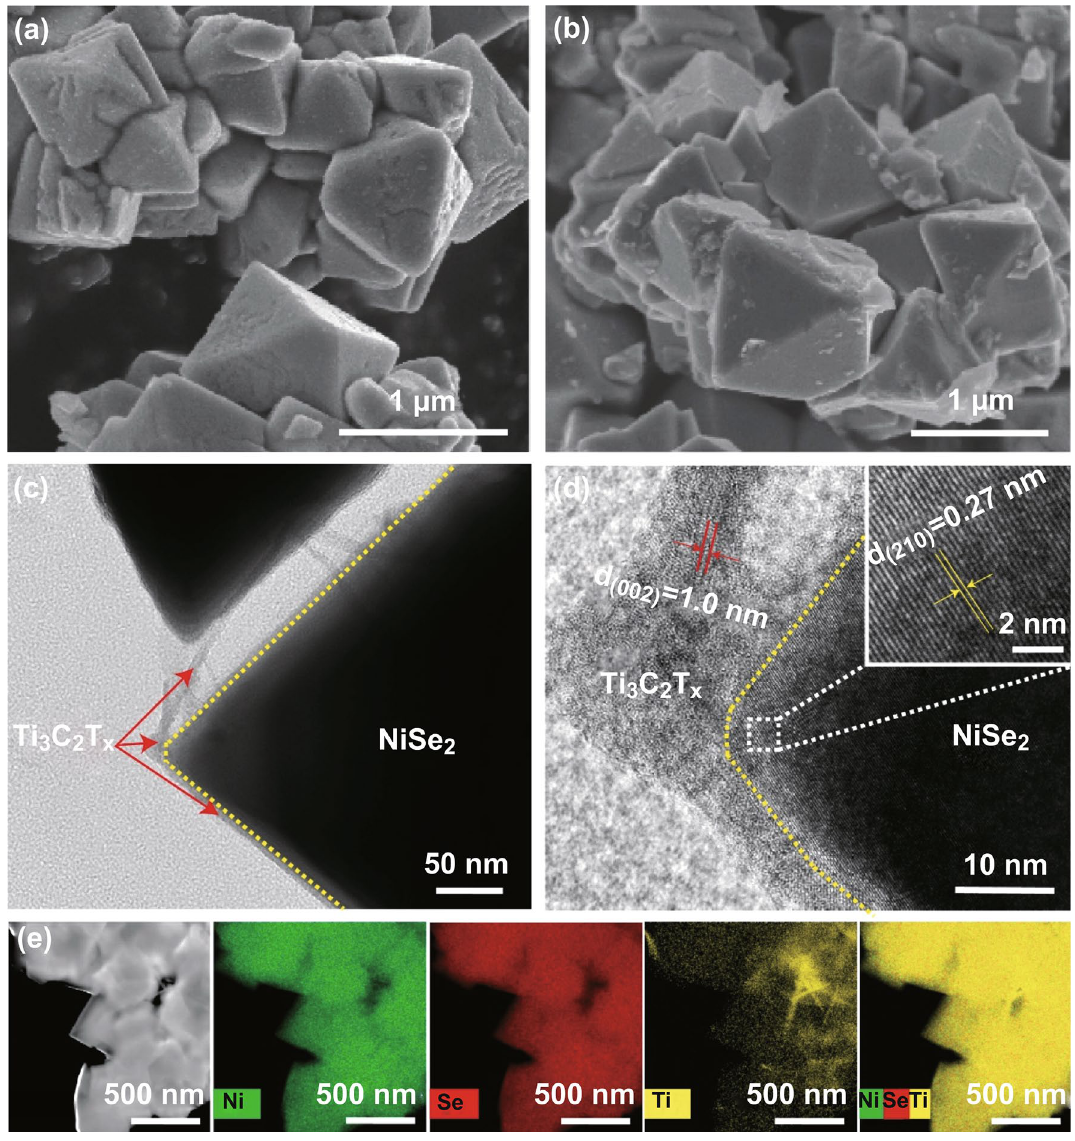
Fig. 1 SEM images of NiSe 2 without ( a ) and with Ti 3 C 2 T x hybrid ( b ). c , d TEM image of NiSe 2 /Ti 3 C 2 T x hybrid in different magnifications. e HAADF‑STEM image of NiSe 2 /Ti 3 C 2 T x hybrid and the corresponding EDX elemental mapping of Ni, Se, and Ti